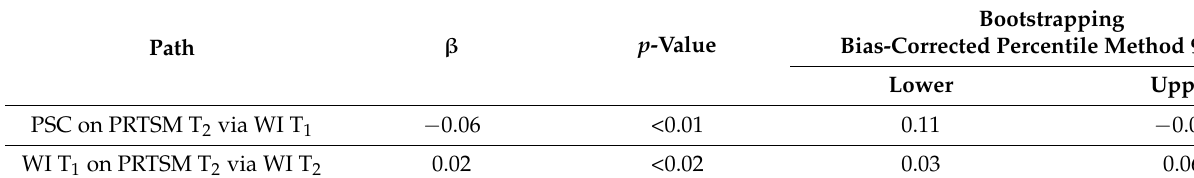
Table 3. Indirect effects: Test of mediation models (hypothesis H1 and H2).